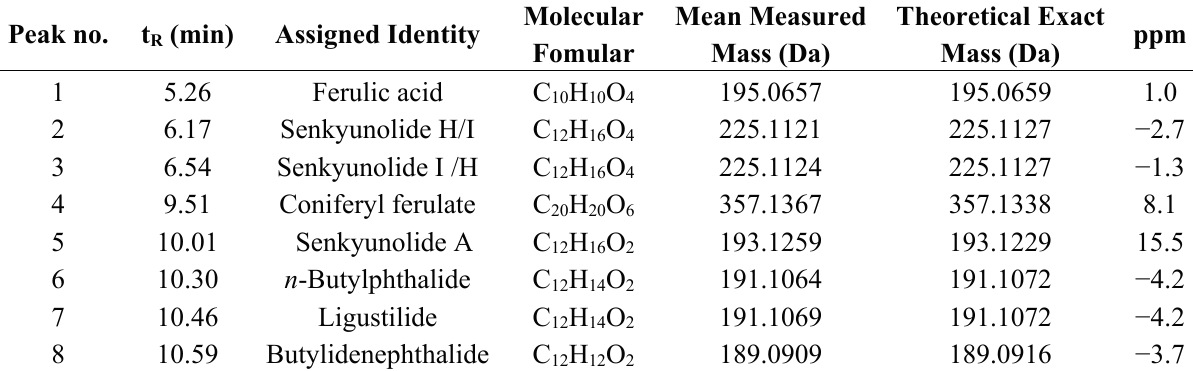
Table 1. Analysis of Angelica sinensis by